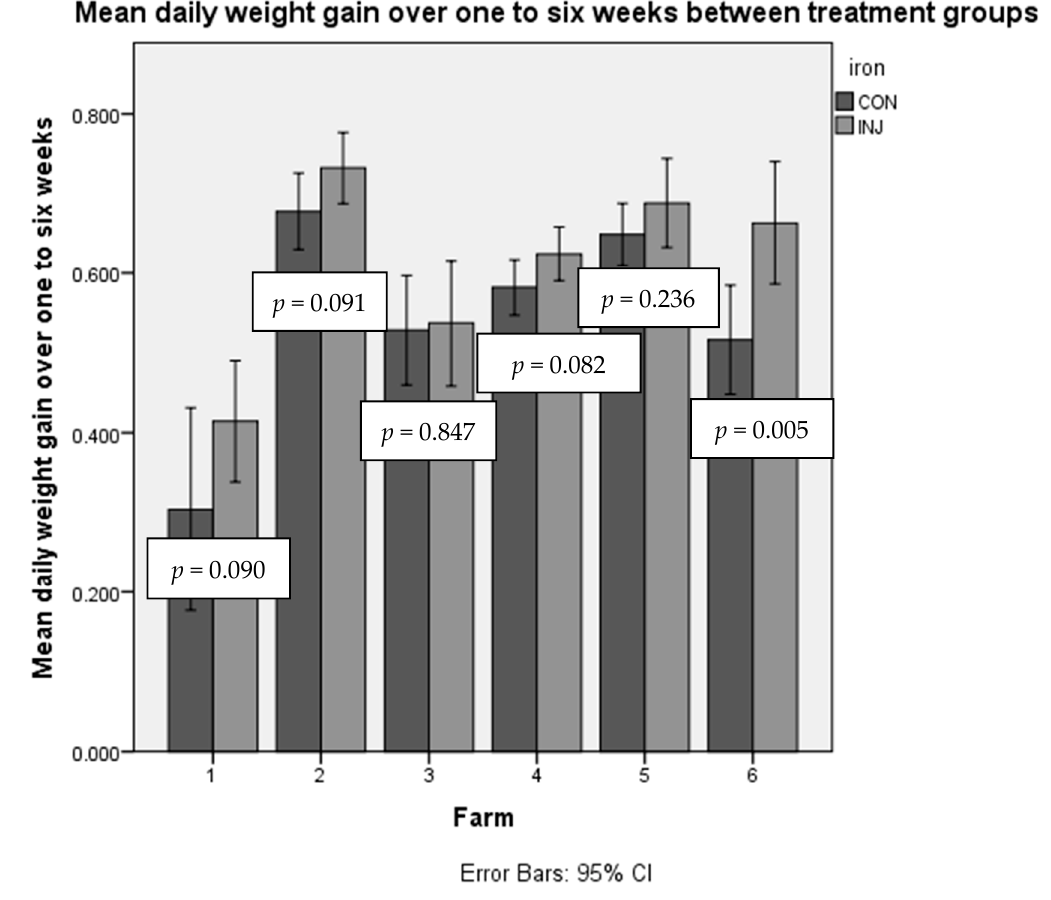
Figure 1. Bar chart showing one- to six-week daily live weight gain (DG) for each farm. Dark grey bars represent CON (control) calves’ average DG on each farm and light grey bars represent INJ (treatment with iron injection) calves’ average DG on each farm. Overall, between all calves, iron increased DG in the INJ group, the difference was 78 g/d (SD 18) ( p < 0.001). Error bars represent the 95% confidence interval. For number of calves in each group and farm, please see Table A1 in the Appendix.